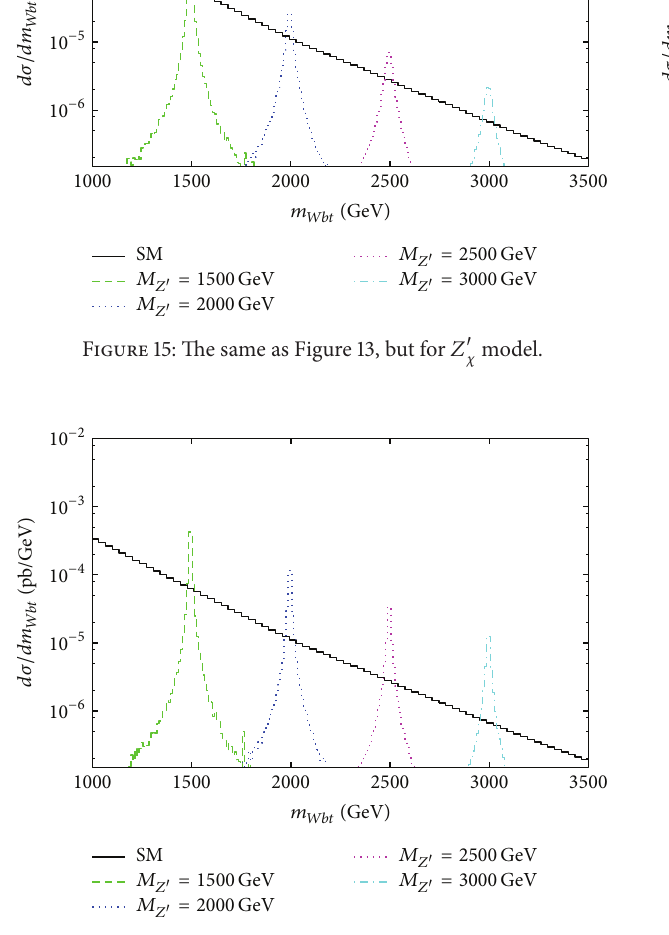
Figure 16: The same as Figure 13, but for 𝑍 󸀠 𝜓 model.